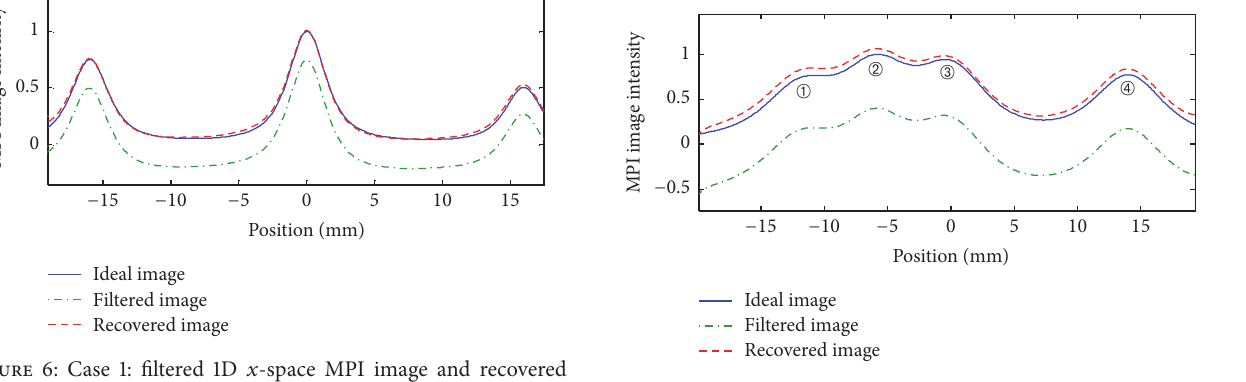
Figure 8: Case 3: filtered 1D 𝑥 -space MPI image and recovered image applying the proposed algorithm for a particle diameter of 22